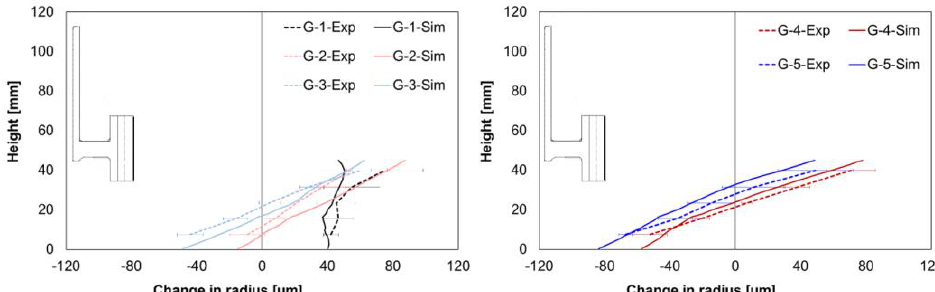
Figure 10. Comparison of the measured and calculated radius changes at the gear tooth for G1–G3 ( left ) and G4–G5 ( right ).